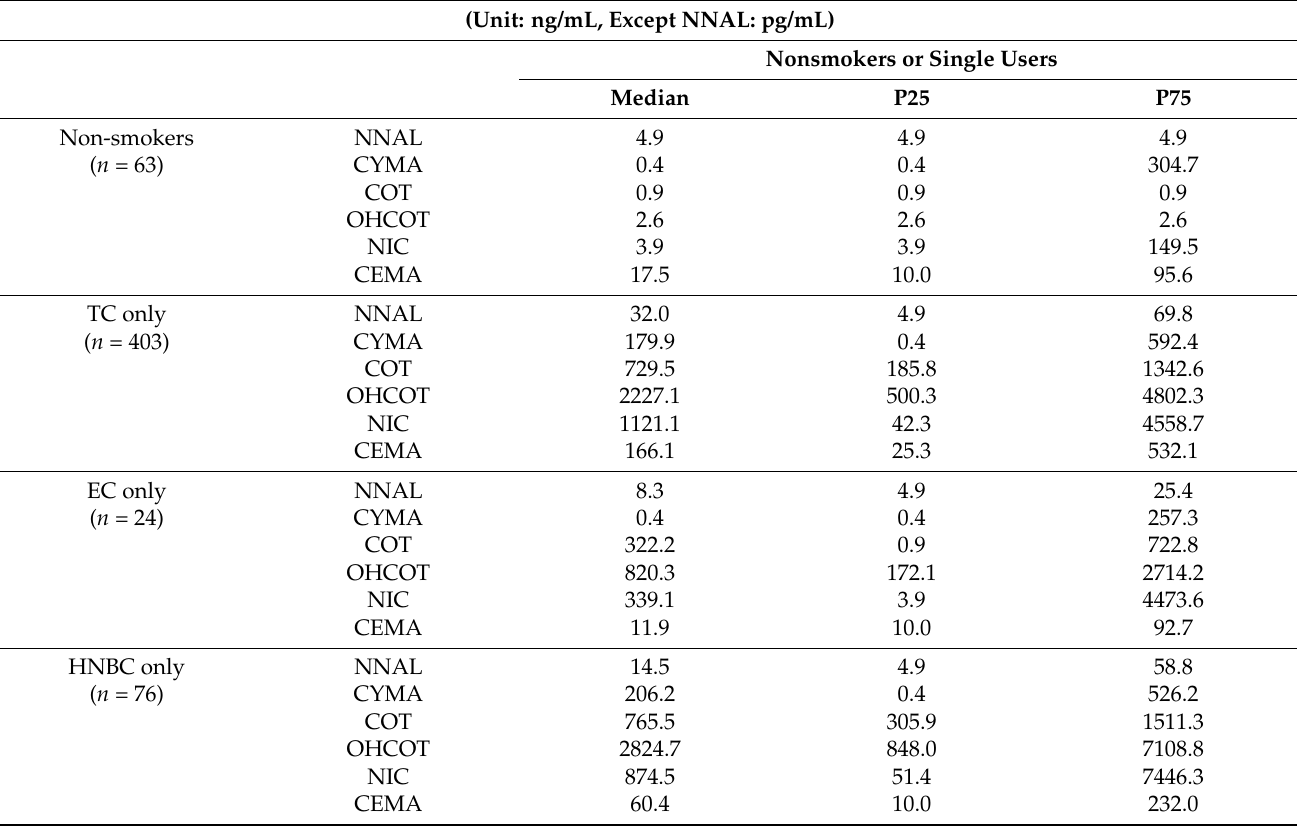
Table 2. Comparison between tobacco product type and biomarker concentration levels among subjects. (Unit: ng/mL, Except NNAL: pg/mL)